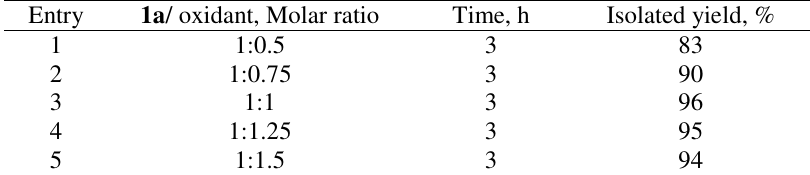
Table 1. The effect of molar ratio of substrate/ oxidant (ACC/M K10) on the oxidation of acetophenone oxime at room temperature